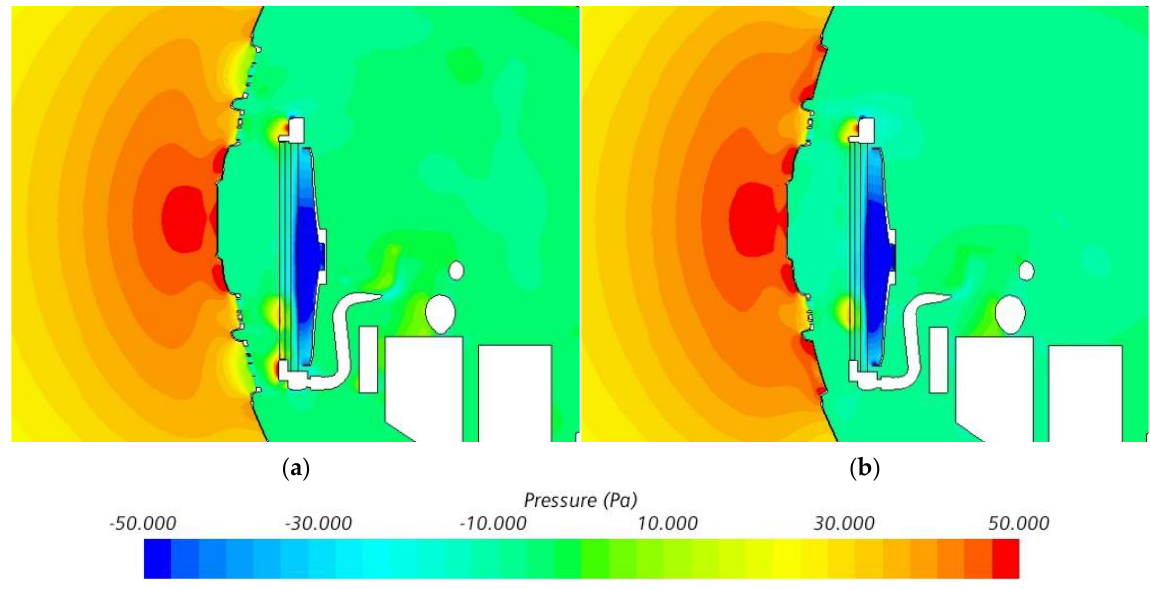
Figure 11. Comparisons of z = 0.44 m section pressure nephogram between scheme 1 and original vehicle: ( a ) original vehicle; ( b ) scheme 1.